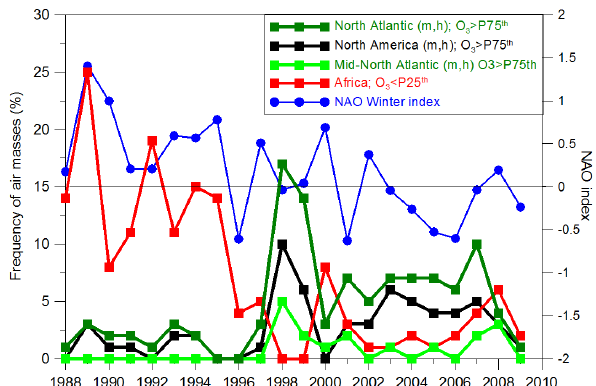
0 . 5 for Fig. 16. Long term frequency of air masses arriving to IZO from Table 6. Mean surface O 3 for NAO > +0 . 5 and NAO < − each season in the period 1988–2009 with the corresponding stan- Africa sector associated with O 3 < P25th, and from North Atlantic Fig. 16. Long term frequency of air masses arriving to IZO from dard deviation of the mean. The third column shows the confidence and North America associated with O 3 > P75th in winter. NAO in- Africa sector associated with O 3 < P 25th, and from North Atlantic level for the difference between the means. dex for winter is also shown. and North America associated with O 3 > P 75th in winter. NAO index for winter is also shown.